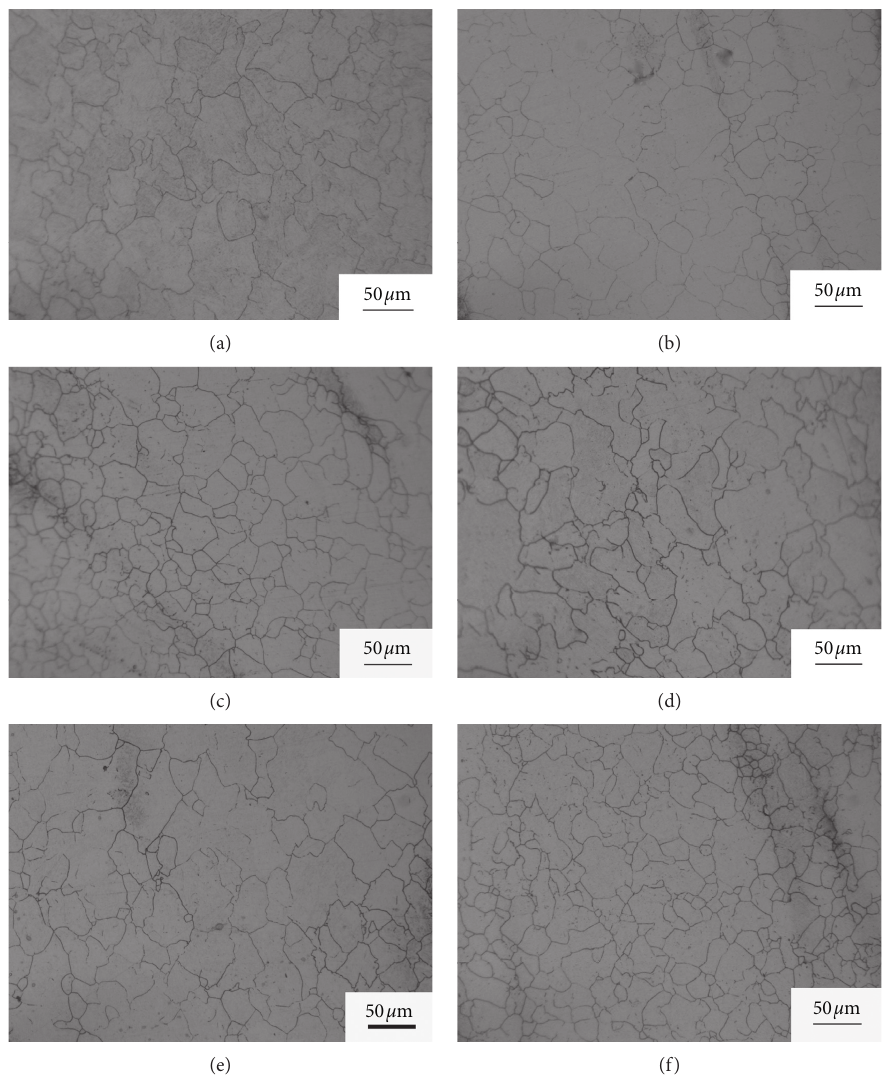
Figure 5: Microstructures of as-cast 42CrMo alloy at different nonisothermal deformation conditions: (a) sample 1; (b) sample 2; (c) sample 8; (d) sample 10; (e) sample 12; (f) sample